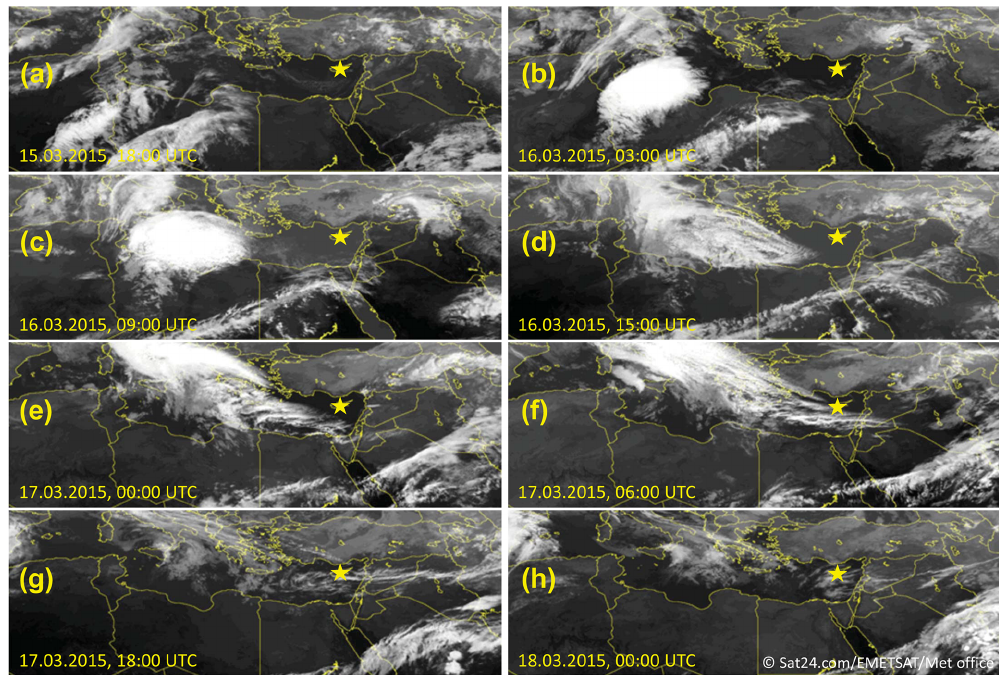
Figure 12. Evolution of a dust-infused baroclinic storm (DIBS) (Fromm et al., 2016) over eastern Algeria and the central Mediterranean Sea on 15 March (a–c) , followed by the decay and dissolution of the anvil cirrus shield on 16 March (d–f) and its transformation into an active cirrus uncinus field extending from Crete to central Asia on 17 March 2015 (f–g) . The lidar site at Nicosia is indicated by a yellow star. The Meteosat Second Generation (MSG) infrared 10.8µm channel images were produced by the European Organization for the Exploitation of Meteorological Satellites